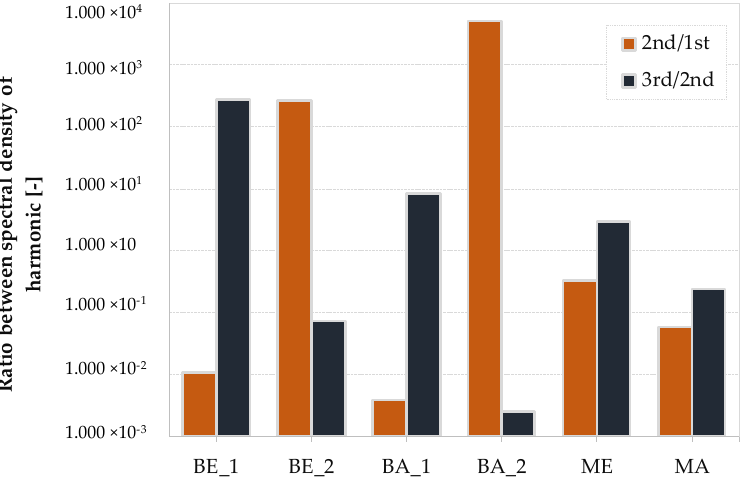
Figure 5. Ratio between spectral density level at different harmonics of the bichromatic and monochromatic tests.